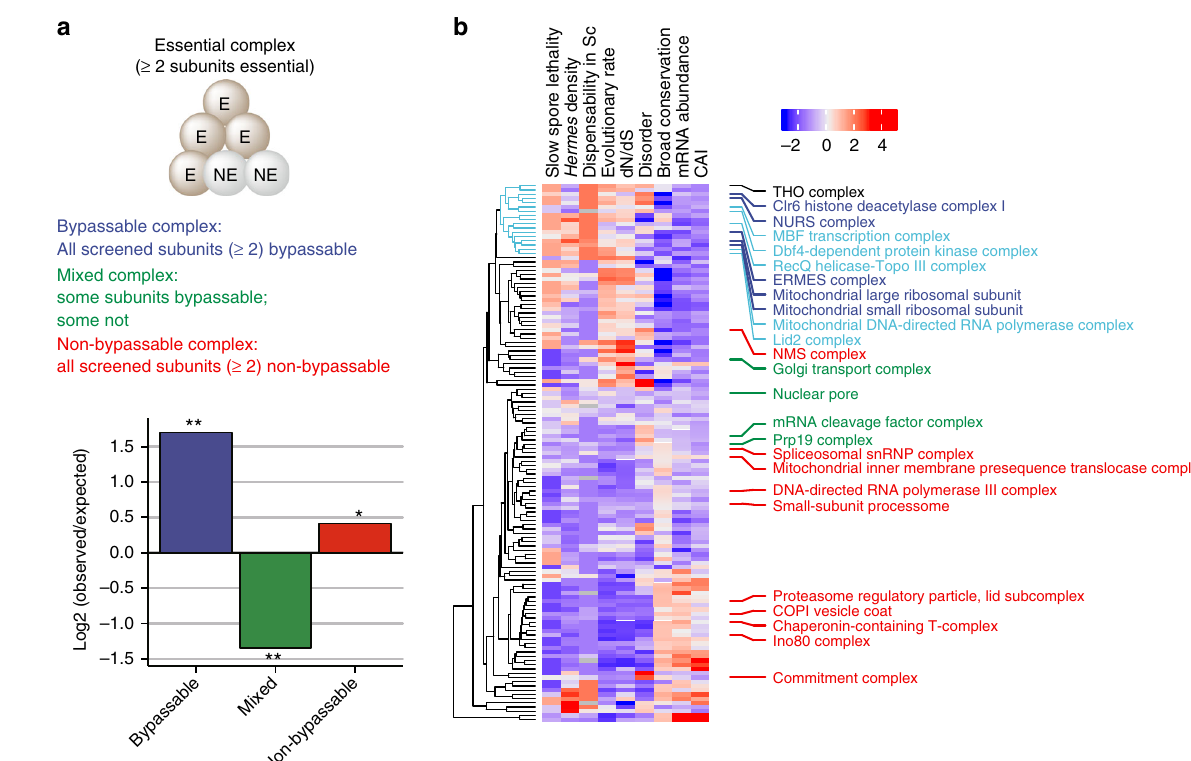
Fig. 4 Bypassability tends to be shared by subunits belonging to the same protein complex. a Subunits of the same protein complex tend to be either all bypassable or all non-bypassable. The observed numbers of the three types of complexes were compared to the expected numbers computed as the arithmetic mean of 1000 random permutations. ** indicates P < 0.01, and * indicates P < 0.05. P values were calculated from the permutations. b Hierarchical clustering of essential protein complexes based on nine features that have the best predictive power for complex bypassability. The complexes named in the fi gure include the bypassable complexes (dark blue), mixed complexes (green), and non-bypassable complexes (red) classi fi ed based on the criteria shown in a . The cluster that all bypassable complexes fall into is highlighted in blue in the dendrogram. Within this cluster, the names of fi ve additional complexes known or expected to be bypassable are in light blue, and the name of the THO complex is in black. The complexes are listed in Supplementary Data 4 in the same order as